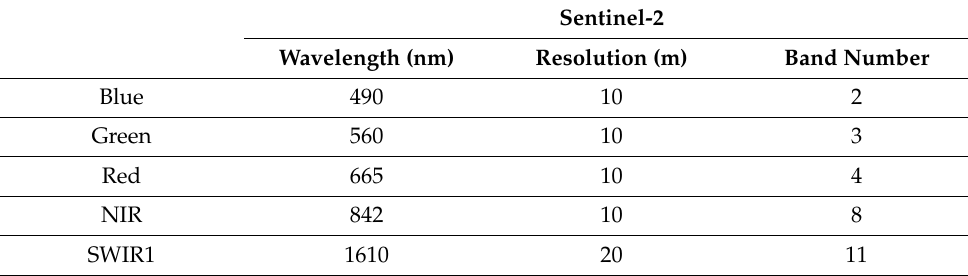
Table 1. Selected Sentinel-2 satellite bands used in this study.